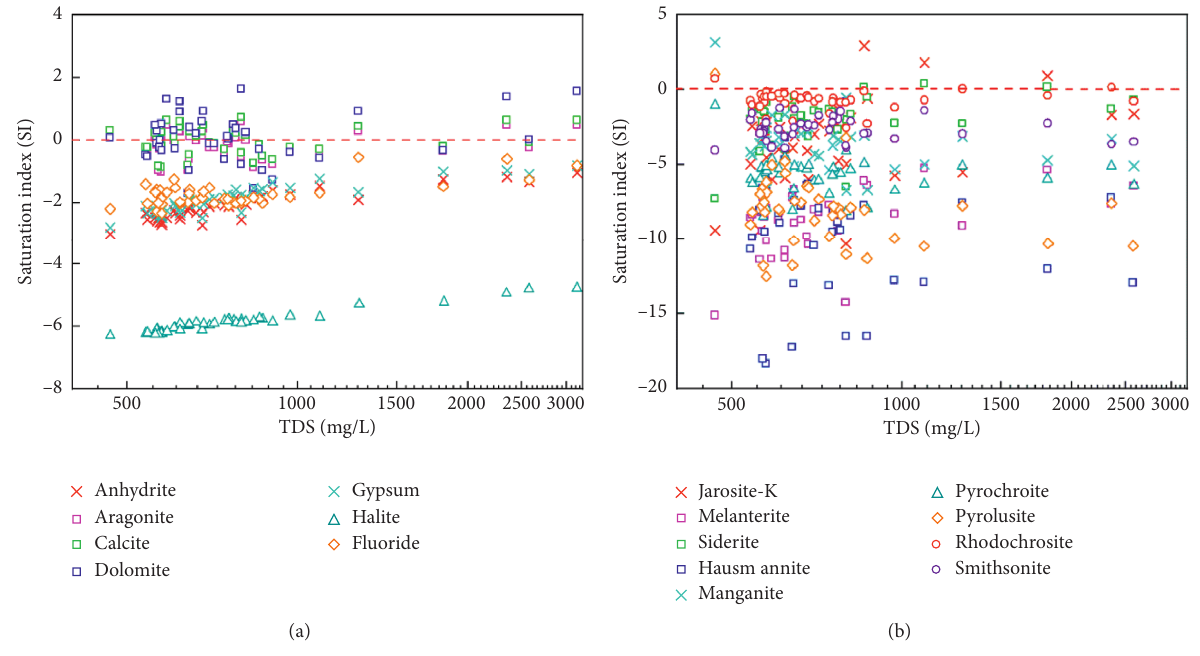
Figure 8: Saturation index of selected minerals in groundwater of the study